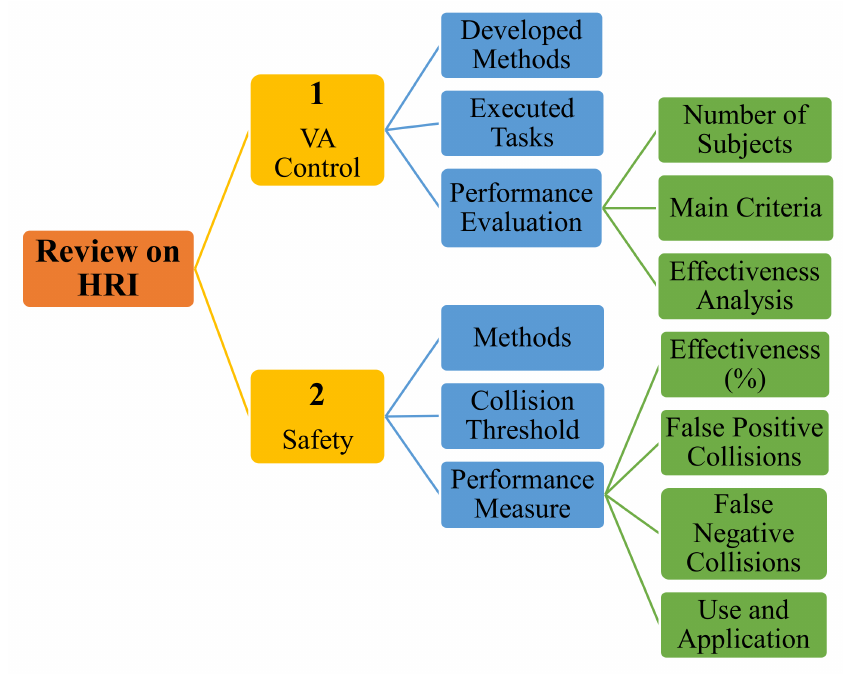
Figure 1. The content of the presented survey on